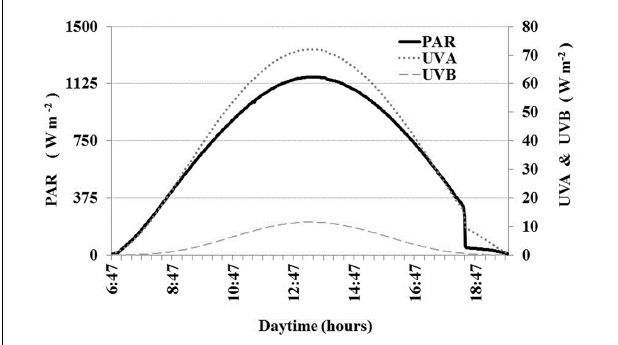
FIGURE 2 | Solar radiation diurnal cycle in Salar de Huasco during November 15, 2013 (radiometer GUV511C). Continuous PAR (left y -axis), UVA and UVB (right y -axis). Incident irradiance was expressed as W m − 2 . Data break at approximately 18:00 was due to sunset behind the surrounding